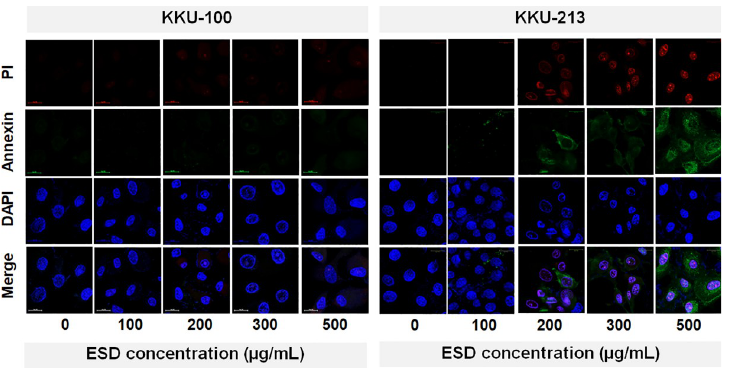
Fig 5. Annexin V/PI staining after ESD treatment for 48